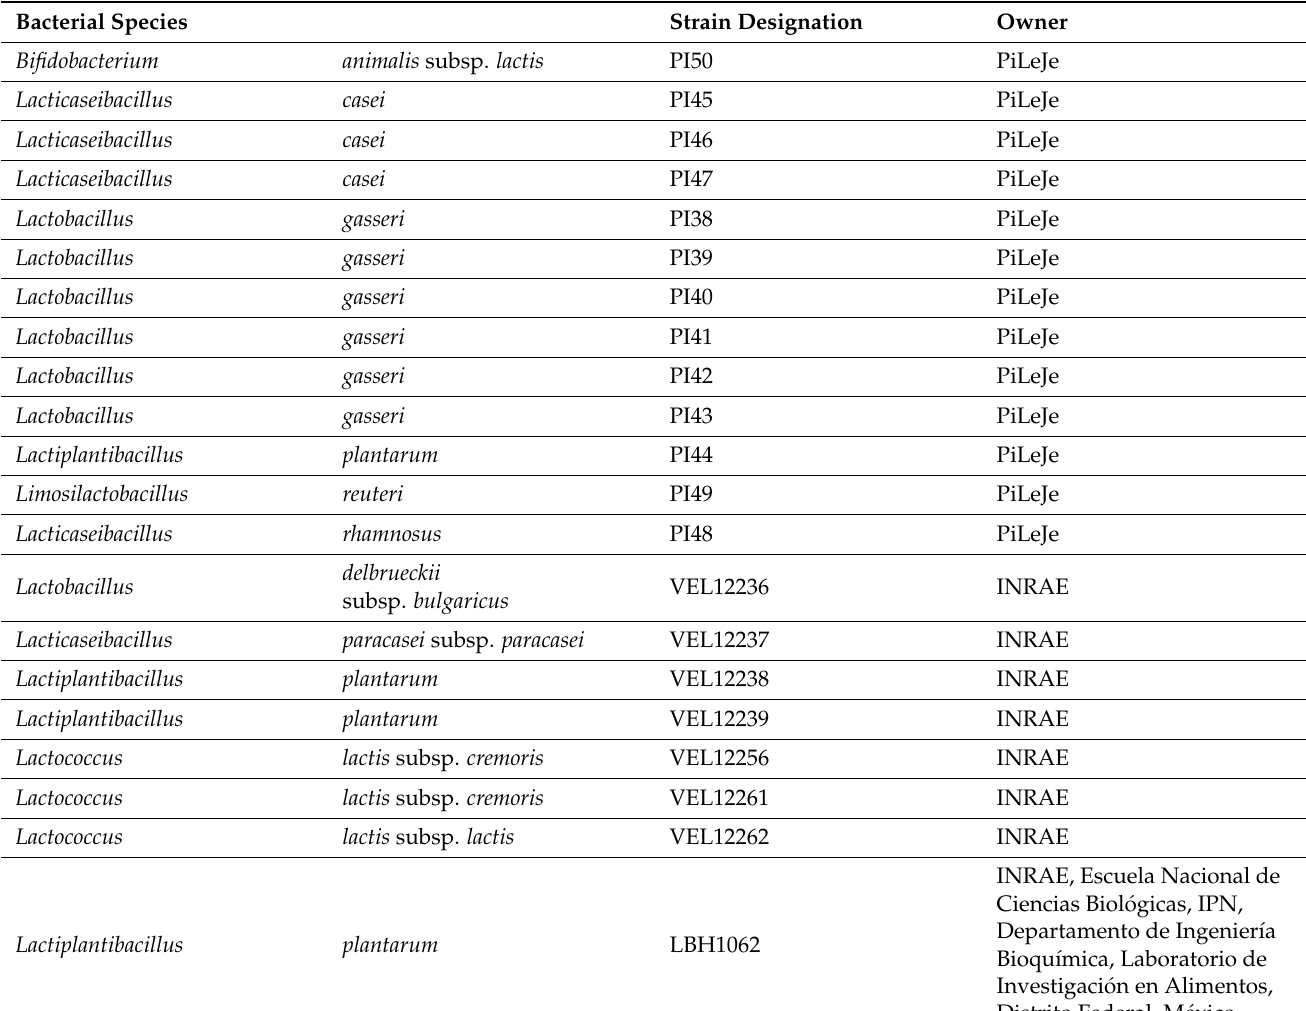
Table 1. Strains included in the in vitro